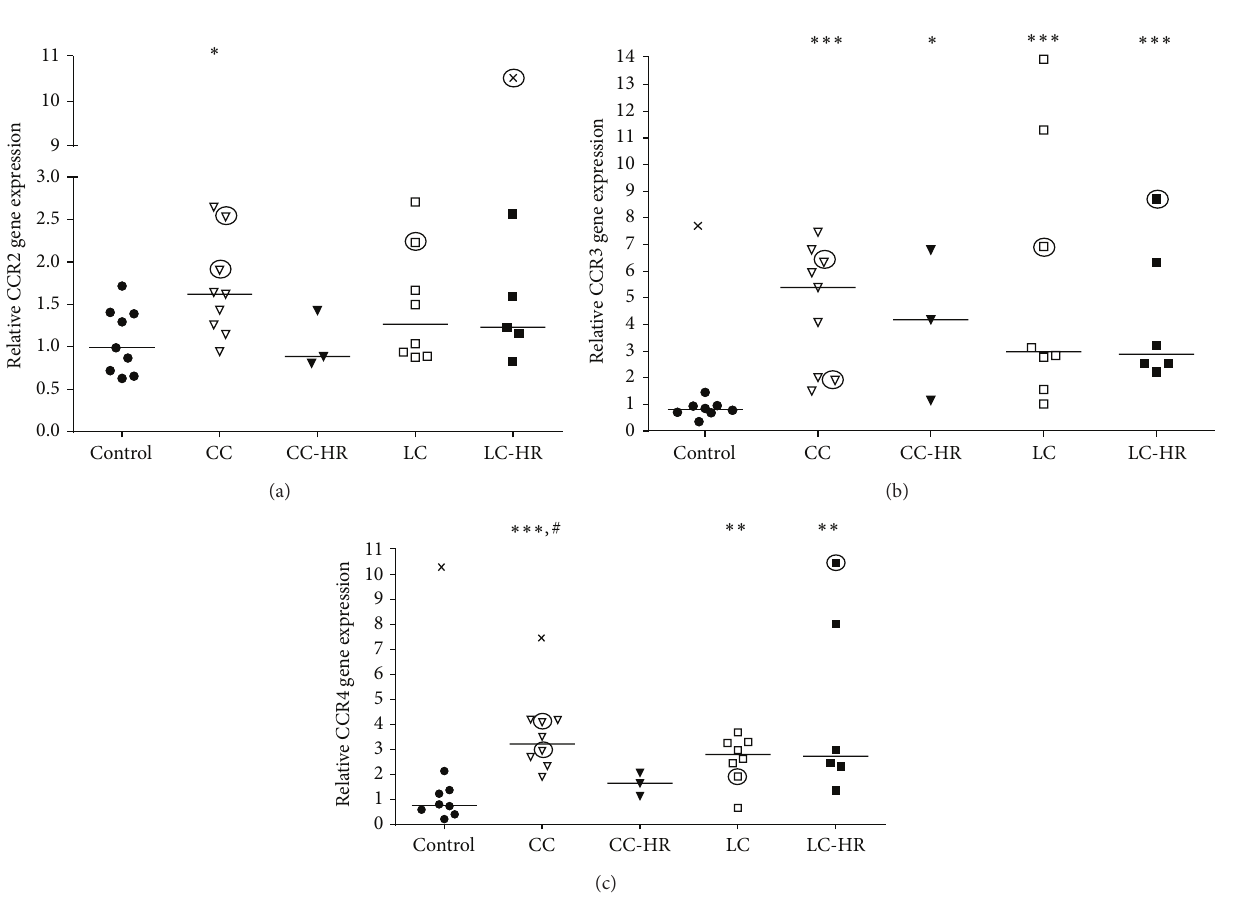
Figure 7: Relative gene expression of the chemokine receptors CCR2, CCR3, and CCR4. Each symbol represents one patient and the medians are depicted as a line. Statistical outliers are marked as crosses (X) and budesonide treated patients are encircled. ∗ 𝑃 < 0.05 , ∗∗ 𝑃 < 0.01 , and ∗∗∗ 𝑃 ≤ 0.001 versus controls and # 𝑃 < 0.05 versus